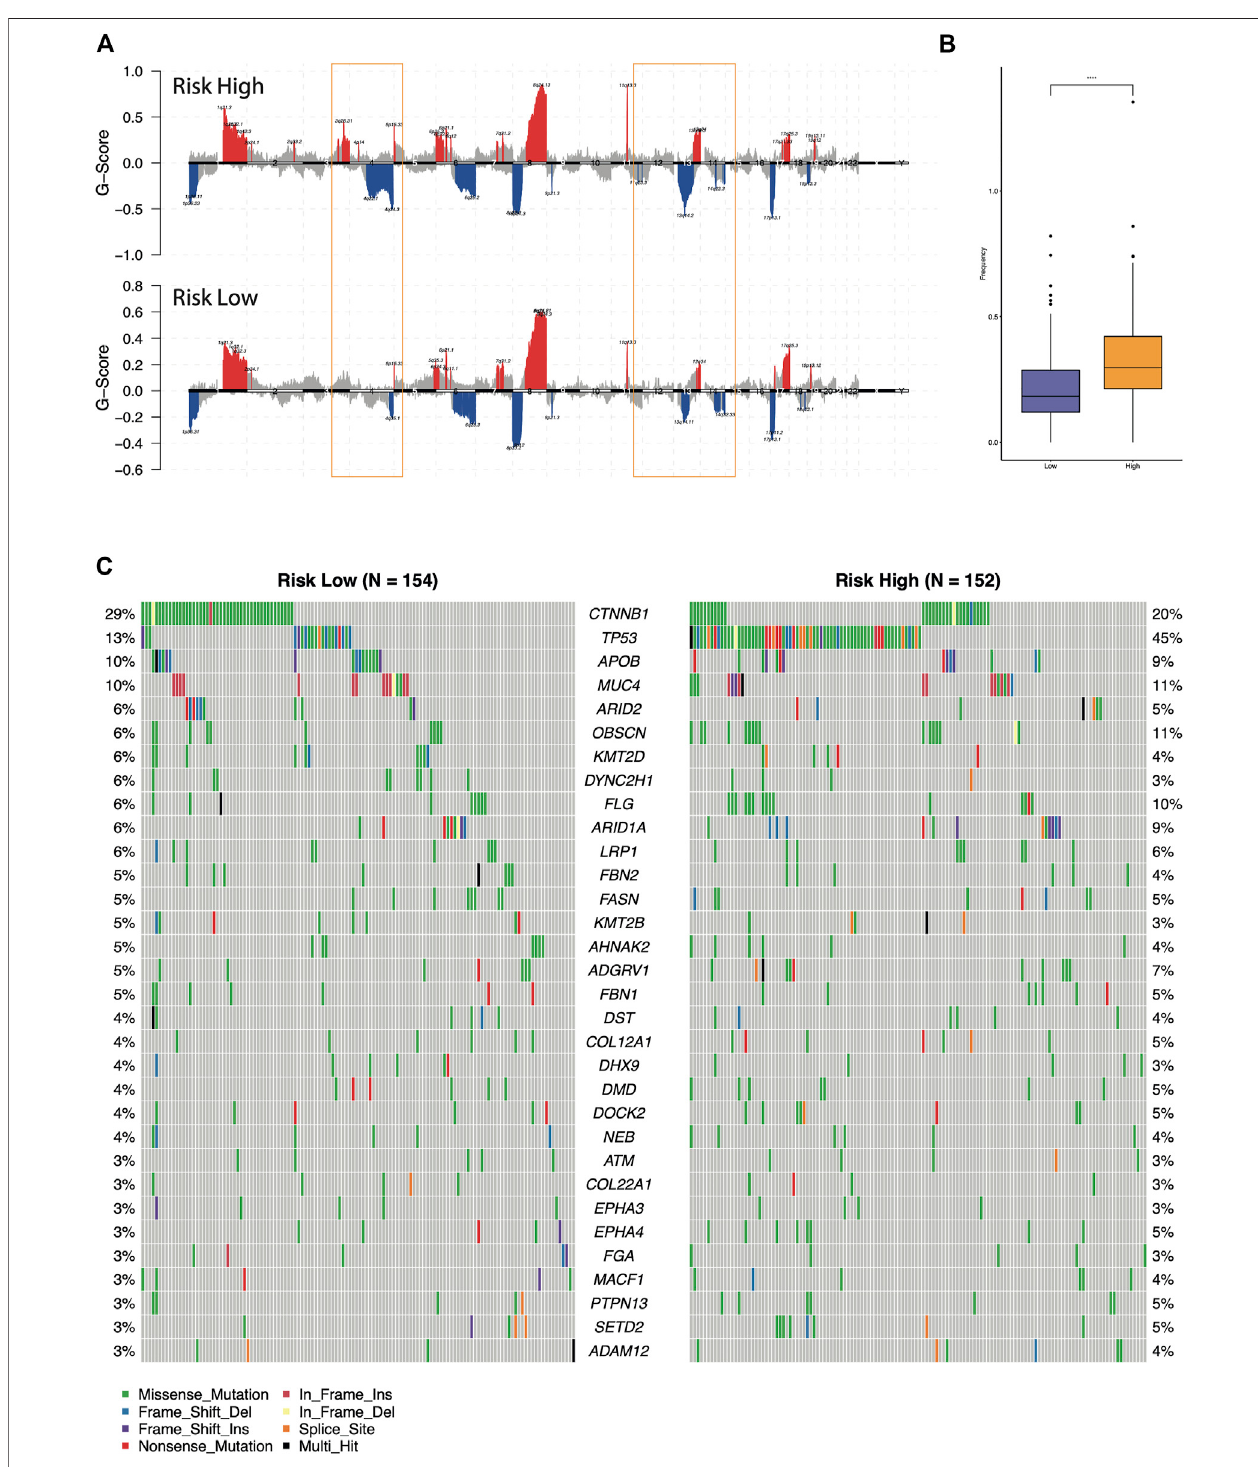
FIGURE5| Comparisonofthegenomicalterationsbetweenthedifferentriskgroups. (A) Recurrentcopynumberaberrationsofthehigh-andlow-riskgroupsinthe TCGA-LIHC cohort. Regions of ampli fi cations (red) and deletions (blue) were above and below baseline (0.0), respectively. The orange box indicated the CNV regions with signi fi cant differences. (B) Comparison of the CNV frequency. (C) Oncoplot of the differential mutated AFs genes between high-risk and low-risk groups.